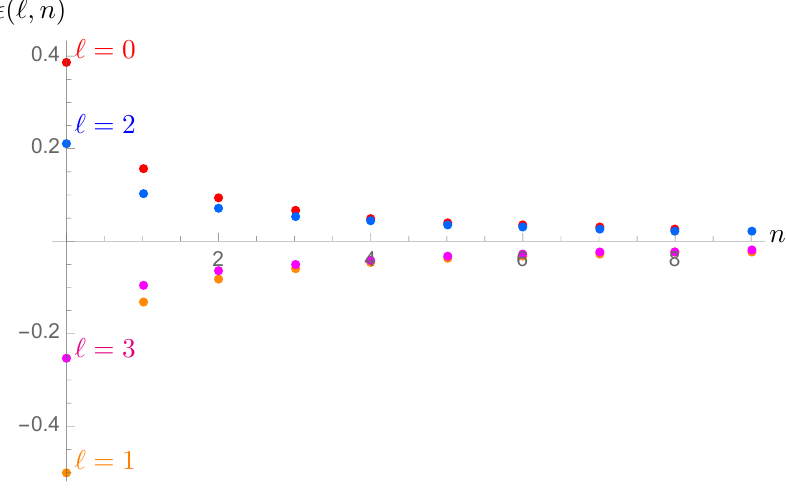
Figure 2 . A plot of the anomalous dimensions (cid:15) ( ‘; n ) of the composite operators described in (4.24) in the spectrum of the isotropic